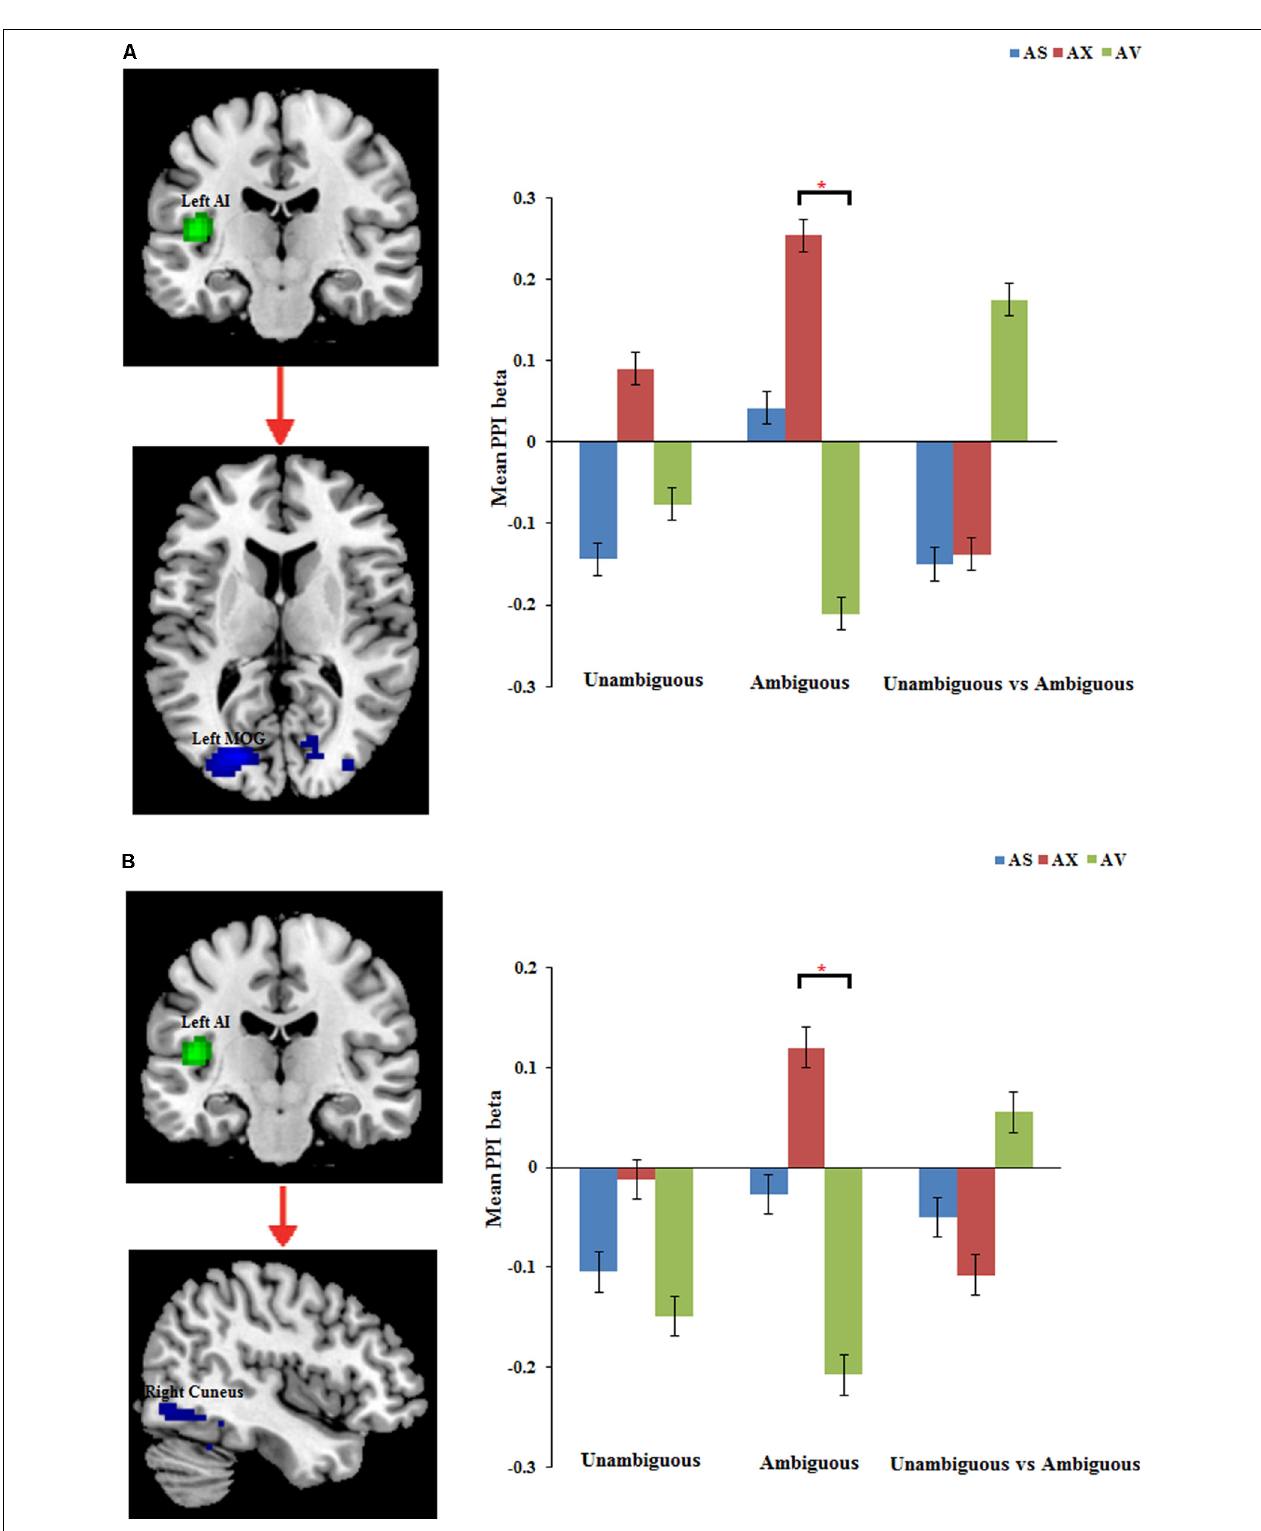
FIGURE 3 | The regions forinteraction between attachment group and Preference condition for left AI. Bar chart displays the mean PPI beta in secure attachment group (blue), anxious attachment group (red) and avoidant attachment group (green) for unambiguous, ambiguous and unambiguous vs. ambiguous conditions. (A) Left AI connectivity with MOG/Fusiform gyrus. (B) Left AI connectivity with Cuneus/Posterior cingulate. Detailed results can be found in Table 6 . The asterisks ( ∗ ) indicate significant differences ( ∗ p ≤